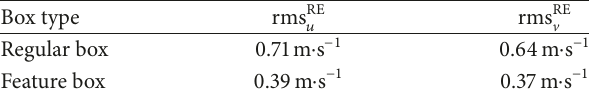
Table 1: Representation error of